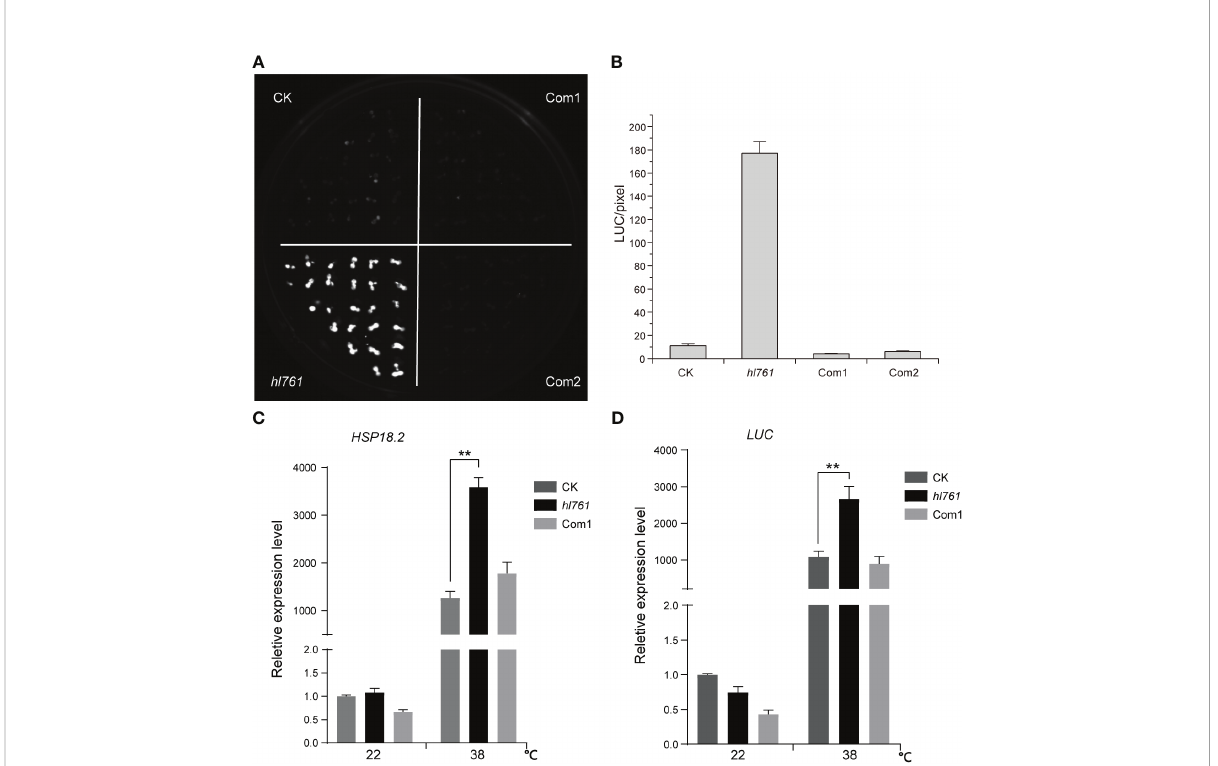
FIGURE 2 Heat-induced high LUC activity in hl761 is complemented by introduced NTR1 . (A) LUC activity in 38°C 1-h heat-treated seedlings of control plant (CK), hl761 mutant, and two independent complemental reference lines, which have single copied pNTR1:NTR1 transgene. (B) Quanti fi cation of LUC activities in seedlings shown in (A) Error bar stands for SE, n = 20. (C) Relative expression of native HSP18.2 in 38°C 1-h heat-treated seedlings of CK, hl761 , and complemental line 1 (Com1). The expression is relative to that of CK without heat treatment. Error bars indicate the SD of three biological replicates. (D) LUC gene expression in 38°C 1-h heat-treated seedlings of CK, hl761 , and complemental line 1 (Com1). The expression is relative to that of CK without heat treatment. Error bars indicate the SD of three biological replicates. Asterisks indicate statistically signi fi cant differences (**p < 0.01 in Student ’ s t-test). CK, background line for hl761